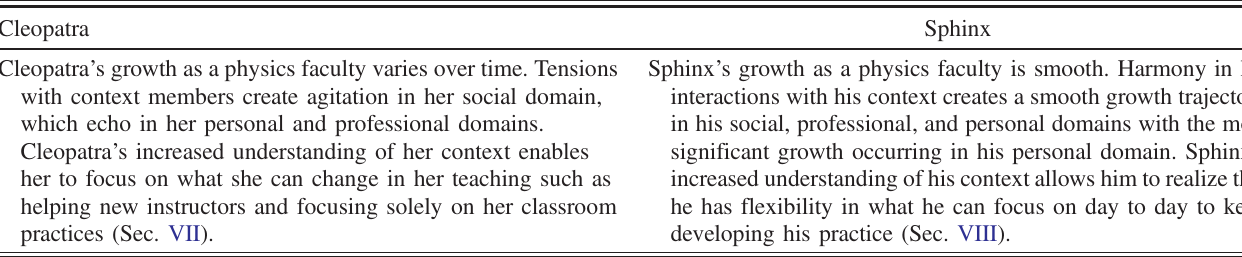
TABLE II. Claims about Cleopatra ’ s and Sphinx ’ s growth.